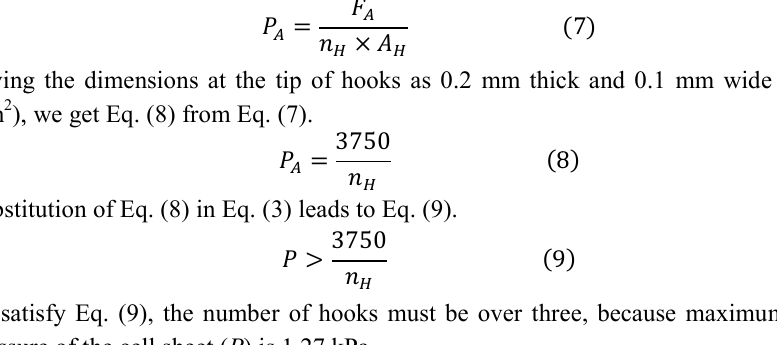
d from the dish bottom, and cell